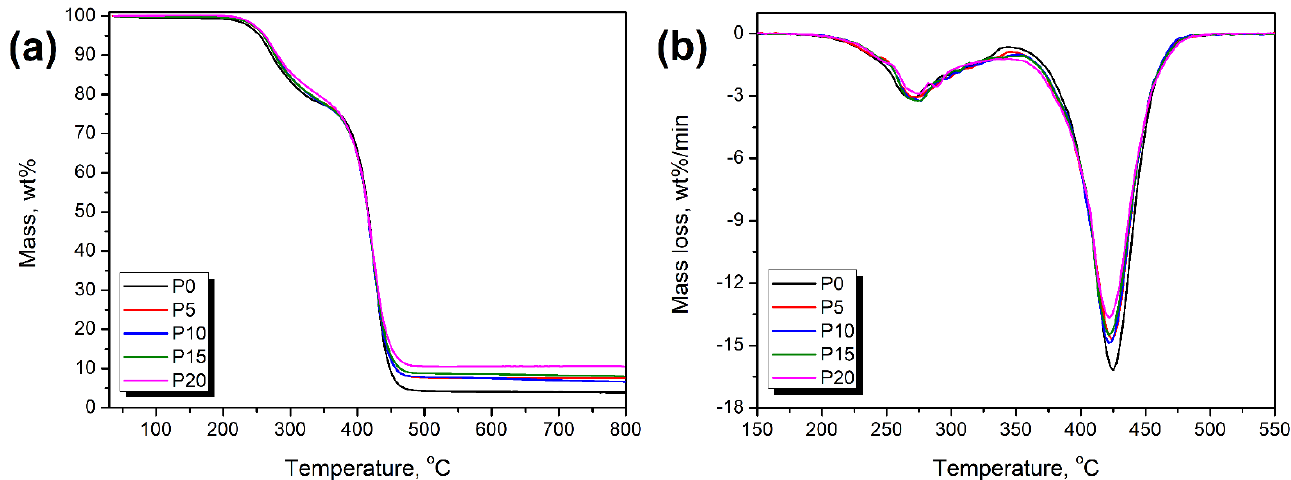
Figure 9. Results of thermogravimetric analysis performed for PU/GTR composite foams and the unfilled PU foam: ( a ) mass loss curves, and ( b ) differential thermogravimetric curves.